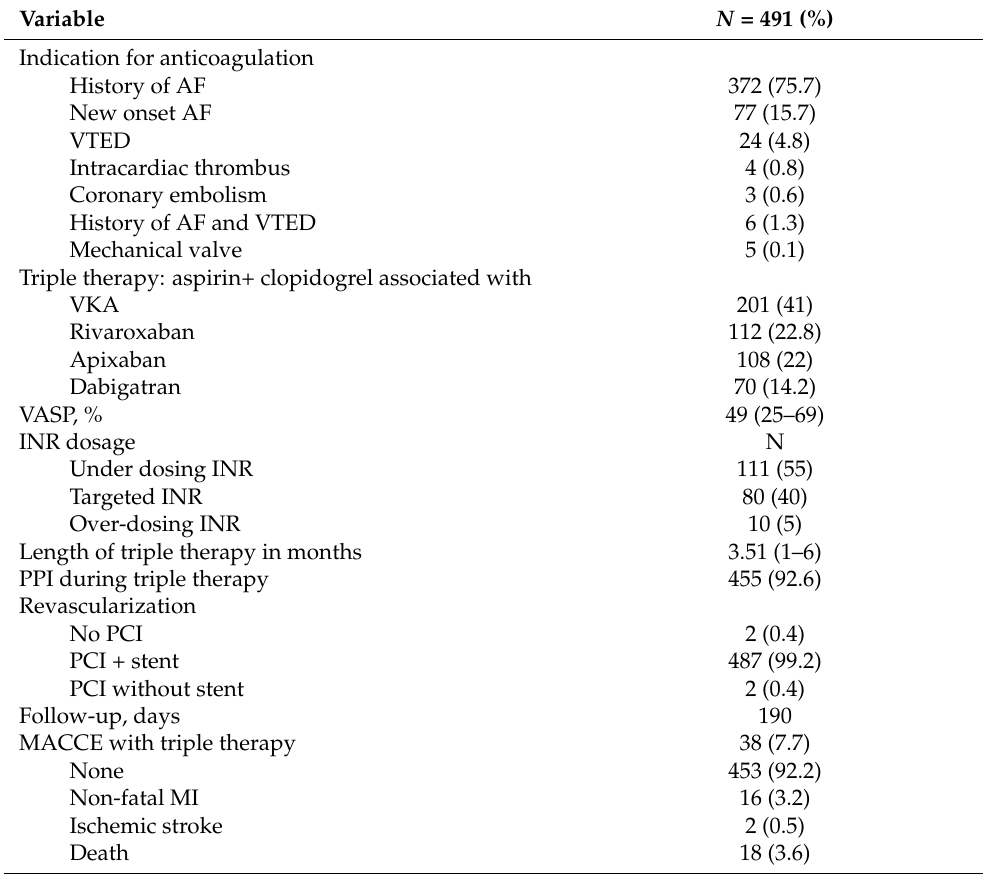
Table 2. Indication for anticoagulation, major adverse cardiac or cerebrovascular events and bleedings for patients with six months follow-up ( N =